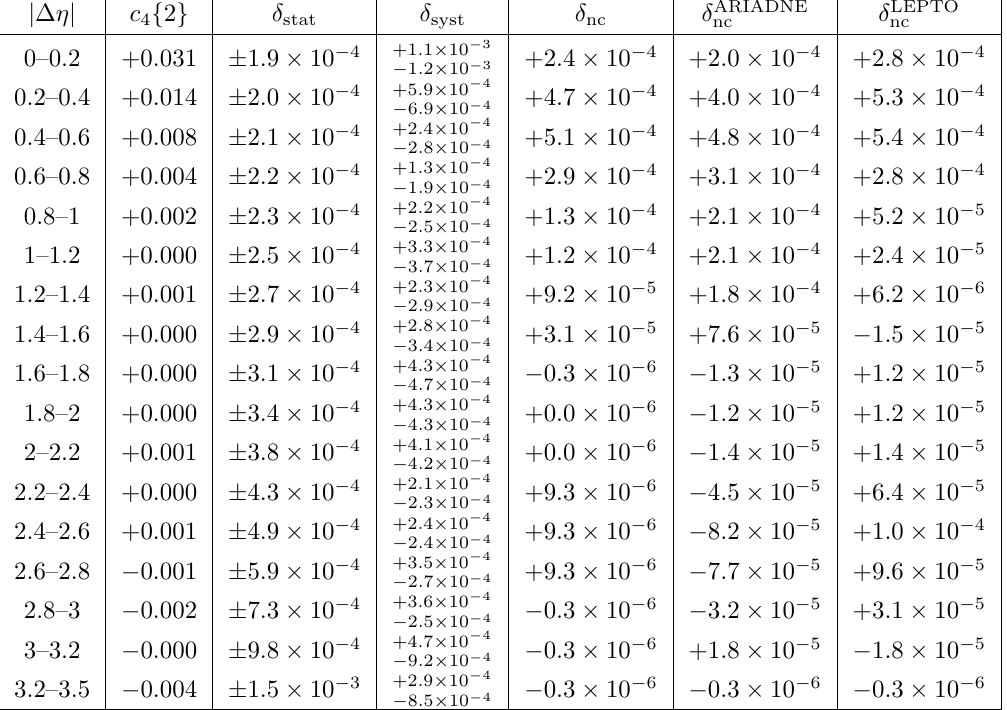
Table 19 . c 4 f 2 g versus j (cid:1) (cid:17) j from (cid:12)gure 8 (d), p T > 0 : 1 GeV; (cid:14) stat , (cid:14) syst and (cid:14) nc denote the statistical, systematic and Monte Carlo non-closure uncertainties,